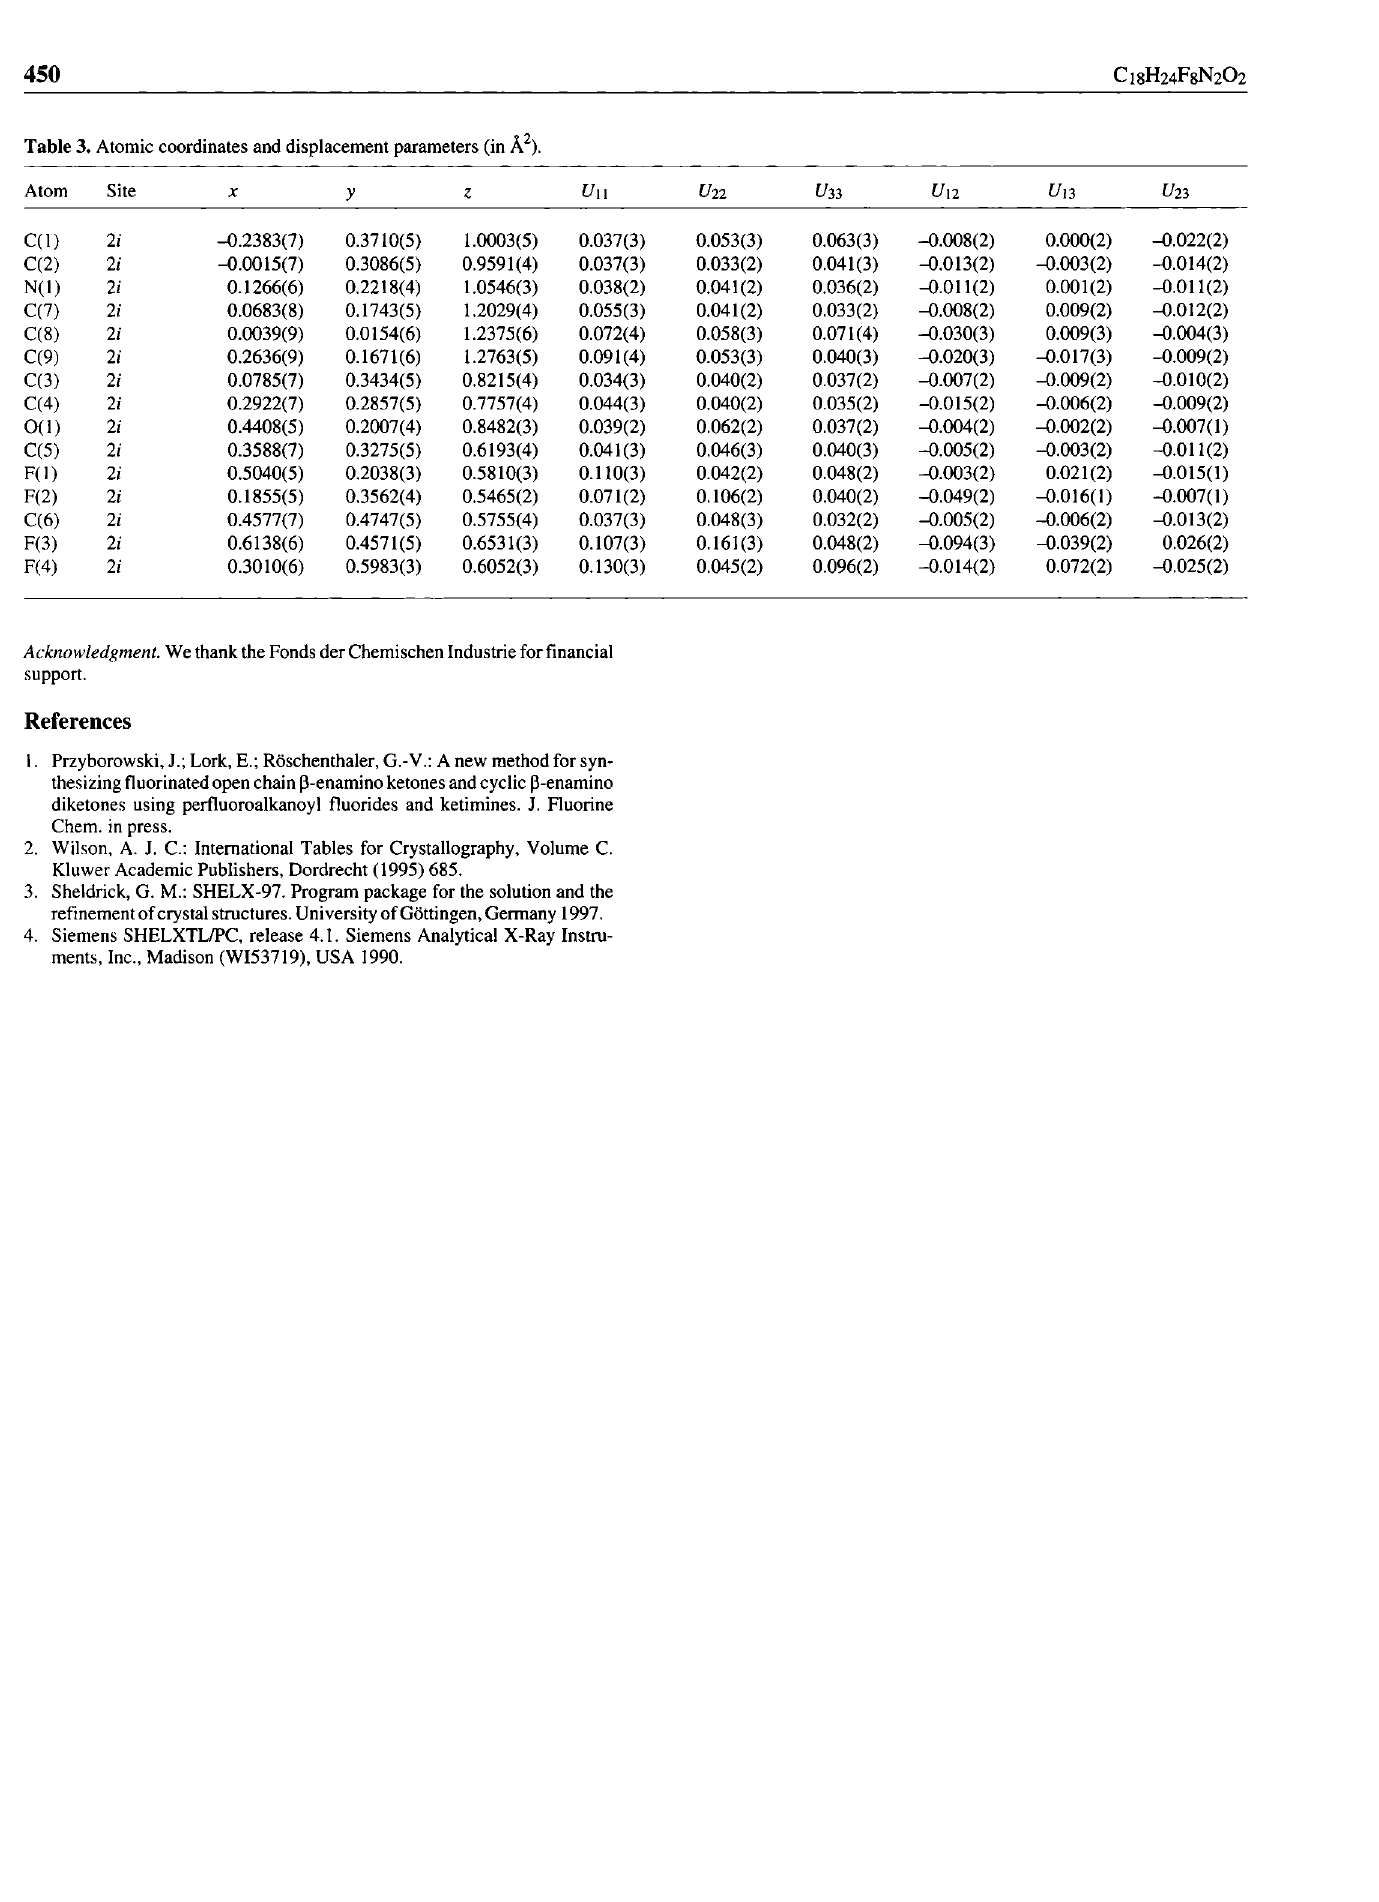
Table 3. Atomic coordinates and displacement parameters (in Ä 2